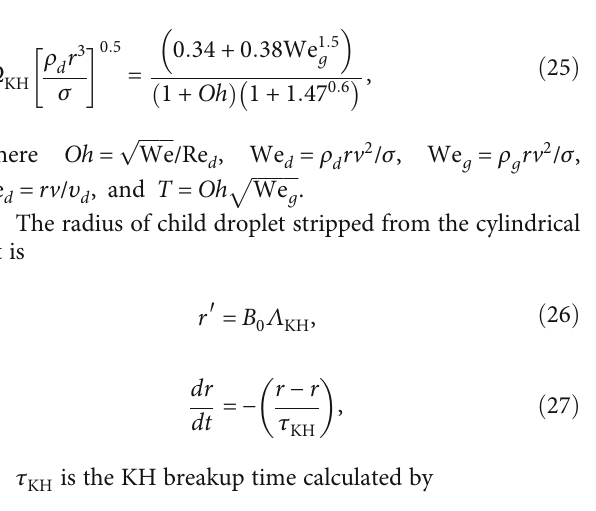
Figure 8: Vertical view of encrypted mesh near the nozzle.